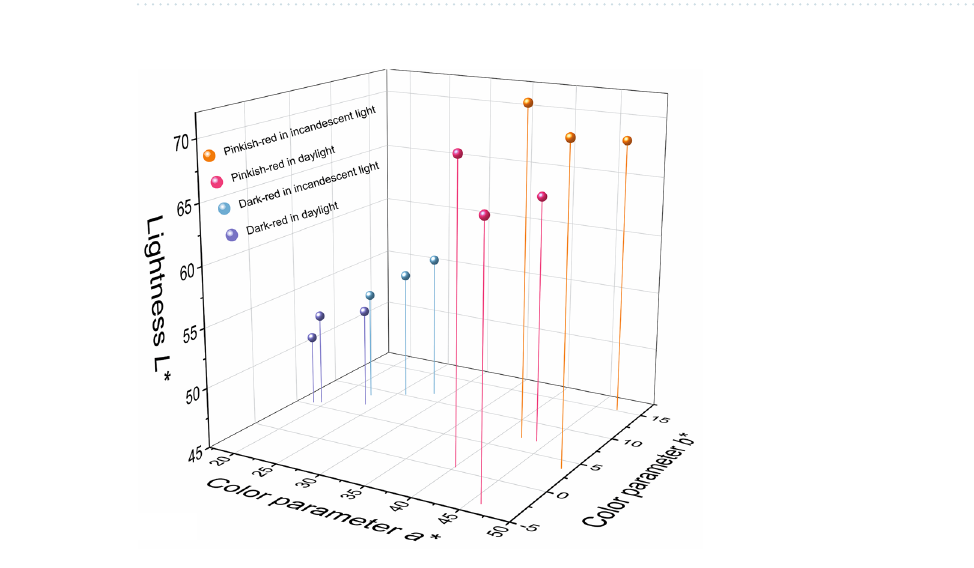
Figure 4. The spinel colors in daylight and incandescent light are plotted in the CIE1976 L * a * b * uniform color space